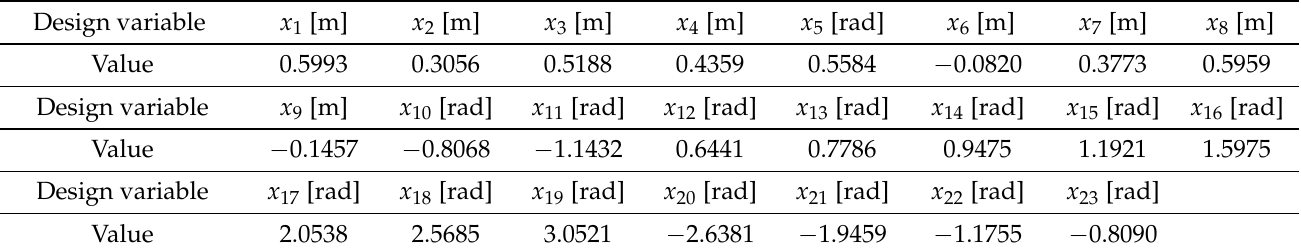
Table 16. Design variable vector obtained by R1B-NCH for study case 1.